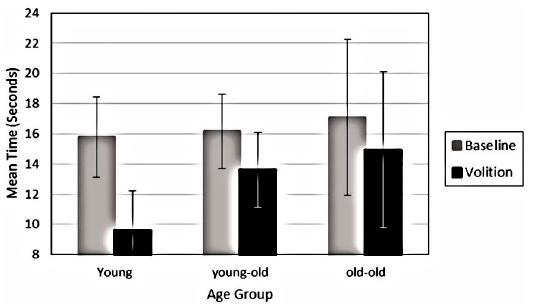
Figure 4. Mean time and standard error in the “down to the left” orientation and following instructions to hold the image in the “up to the right” orientation for younger adults, young-old and old-old adults.